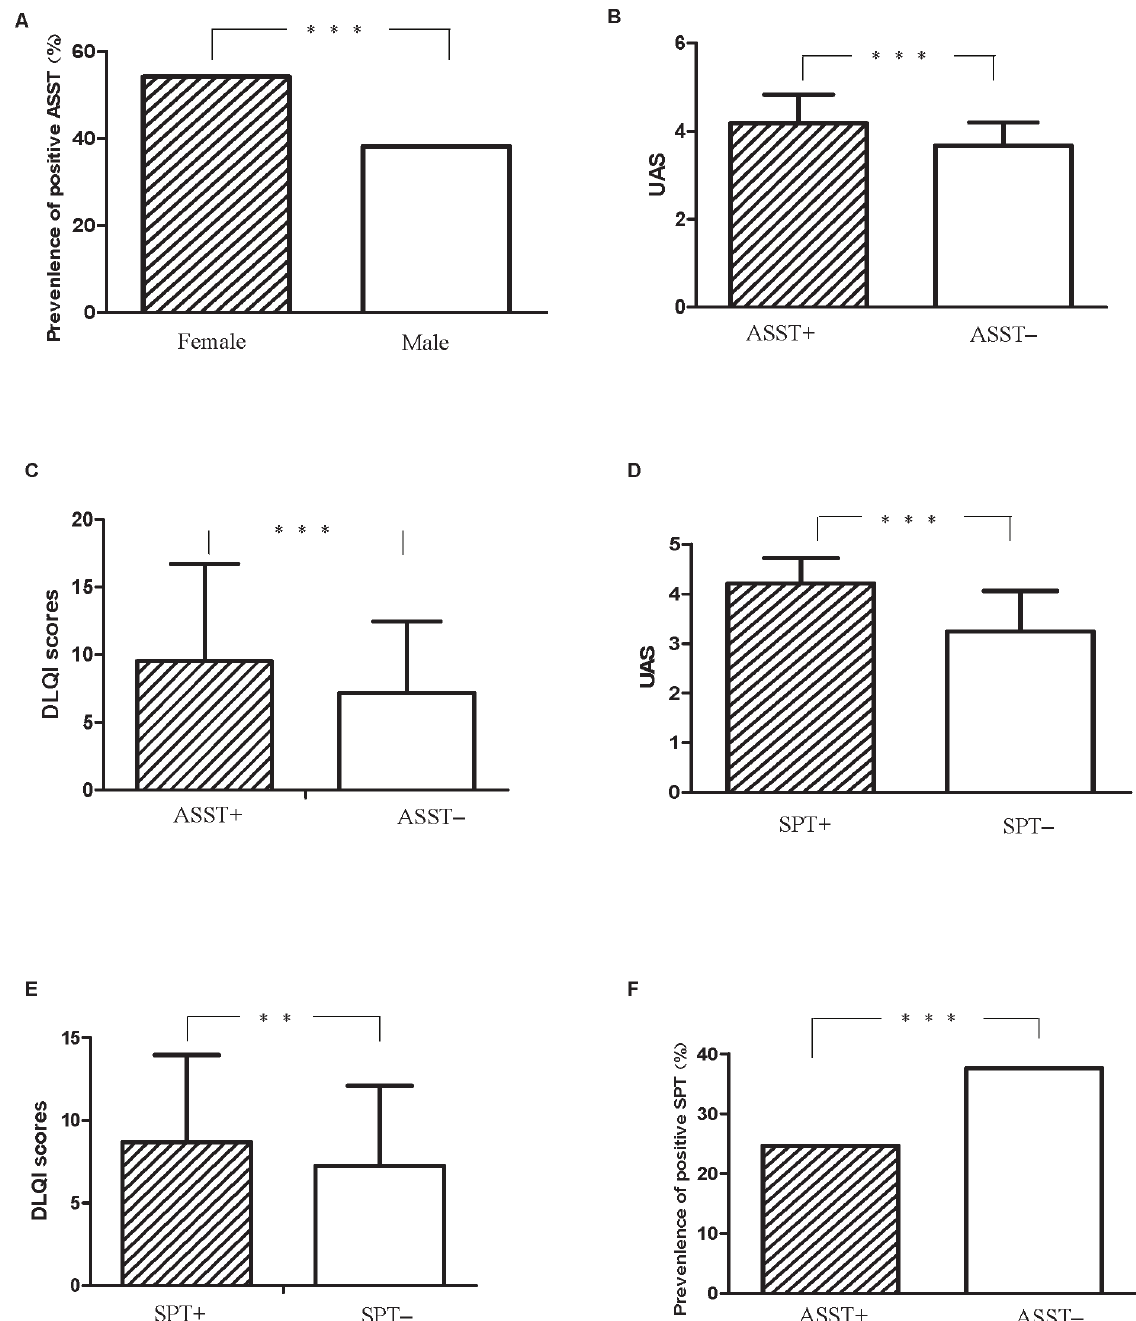
Figure 1. Detection of autologous serum skin test and skin prick test to HDM in 862 patients with chronic spontaneous urticaria. A. Comparison of percent of positive ASST in female patients and male patients. B. Comparison of urticaria activity scores (UAS) between patients with positive ASST and patients with negative ASST. C. Comparison of DLQI scores between patients with positive ASST and patients with negative ASST. D. Comparison of UAS between patients with positive SPT and patients with negative SPT. E. Comparison of DLQI scores between patients with positive SPT and patients with negative SPT. F. Comparison of percent of positive SPT reactions between patients with positive ASST and patients with negative ASST.